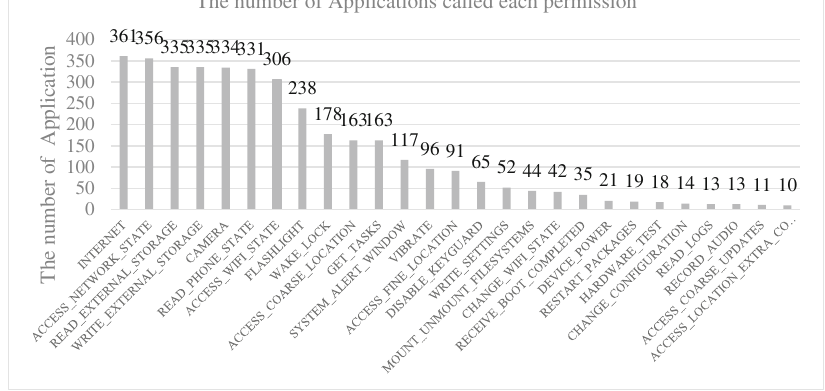
Fig. 7. The number of Apps called